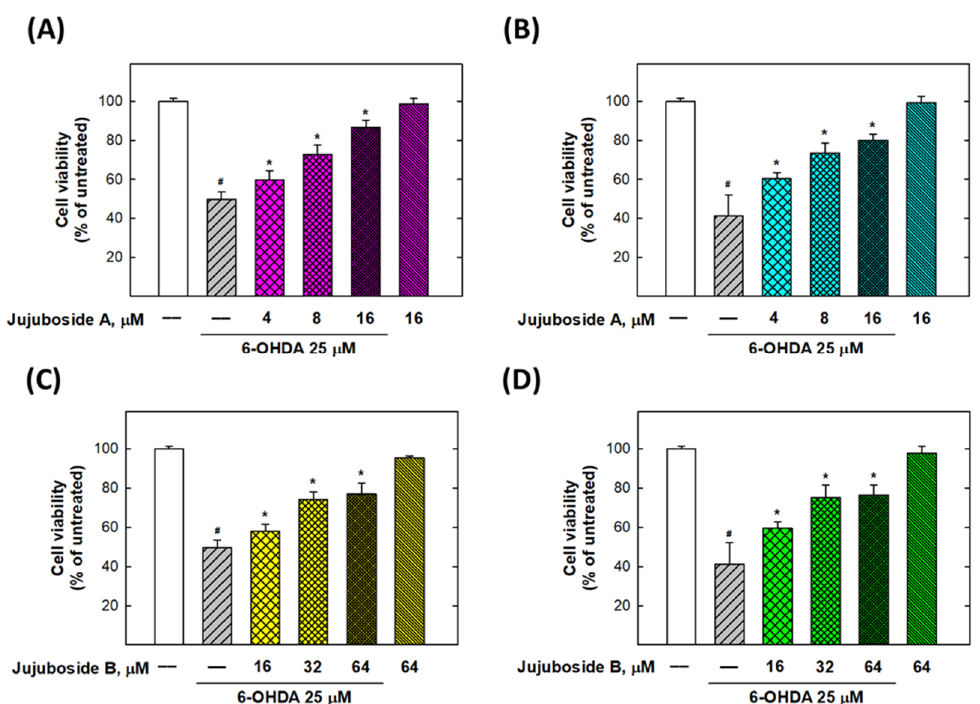
Figure 3. Jujuboside A and B reversed the 6-OHDA-induced loss of cell viability in SH-SY5Y and SK-N-SH cells. ( A , B ) Effects of jujuboside A on SH-SY5Y and SK-N-SH cell viabilities, respectively. ( C , D ) Effects of jujuboside B on SH-SY5Y and SK-N-SH cell viabilities, respectively. * Statistically significant from 6-OHDA 25 μM group. # Statistically significant from untreated group. Each experiment was repeated for at least 6 times.